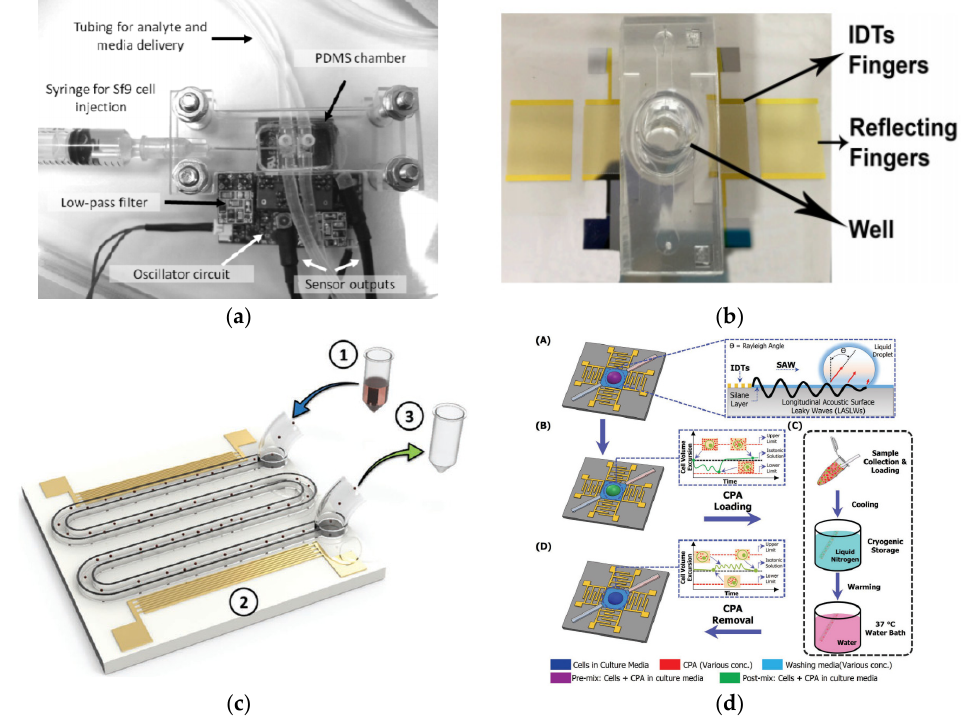
Figure 11. ( a ) Dual SAW biosensor with its oscillator system [84] ( b ) Fabricated SAW device with microfluidic well [86] ( c ) Design of SAW device with a serpentine channel [87] ( d ) The loading and unloading theory and details of the SAW-based CPA [88]. Images were reproduced with permission from references [84,86–88].